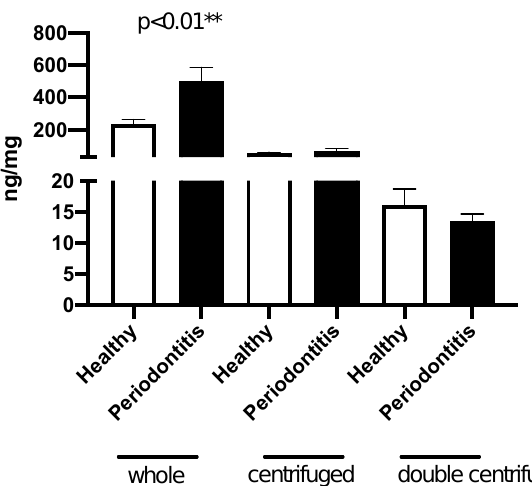
Figure 1. Total DNA in whole saliva, centrifuged saliva (1600× g ) and double-centrifuged saliva (1600× g + 16,000× g ). Results are expressed as mean + SEM. Salivary DNA is higher in periodontitis in whole saliva ( p < 0.01**). No differences were found in centrifuged and double-centrifuged samples between the healthy and periodontitis group.